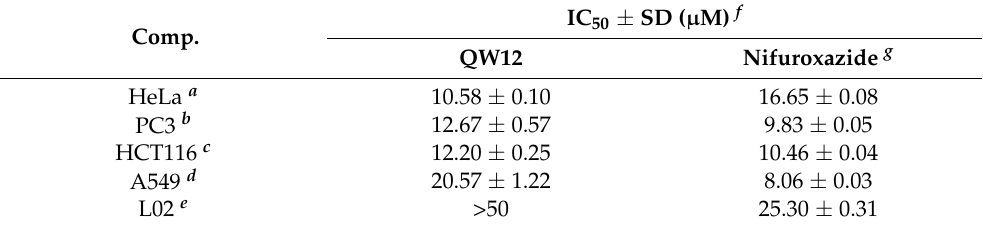
Table 2. Antiproliferative activities of QW12 against various cancer cell lines and normal cells. Comp.